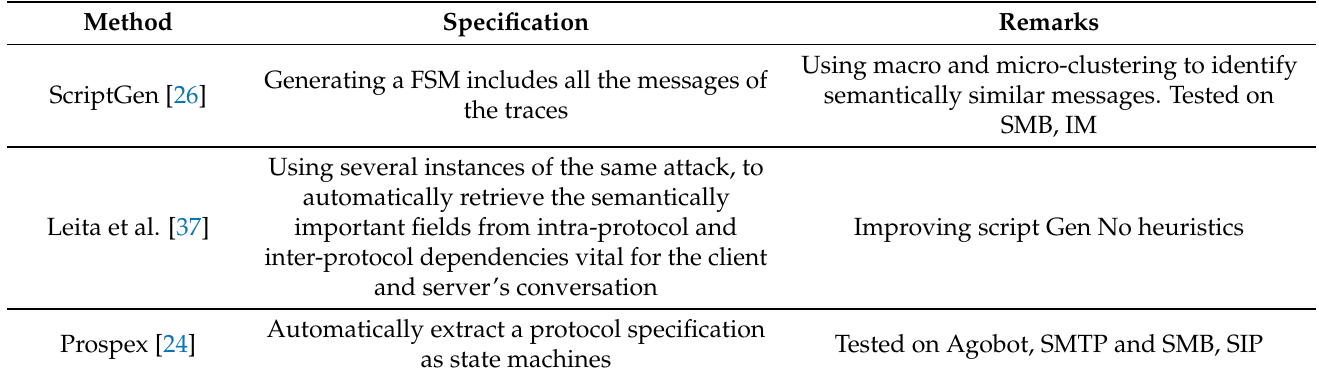
Table 3. Different approaches of inferring control model from network